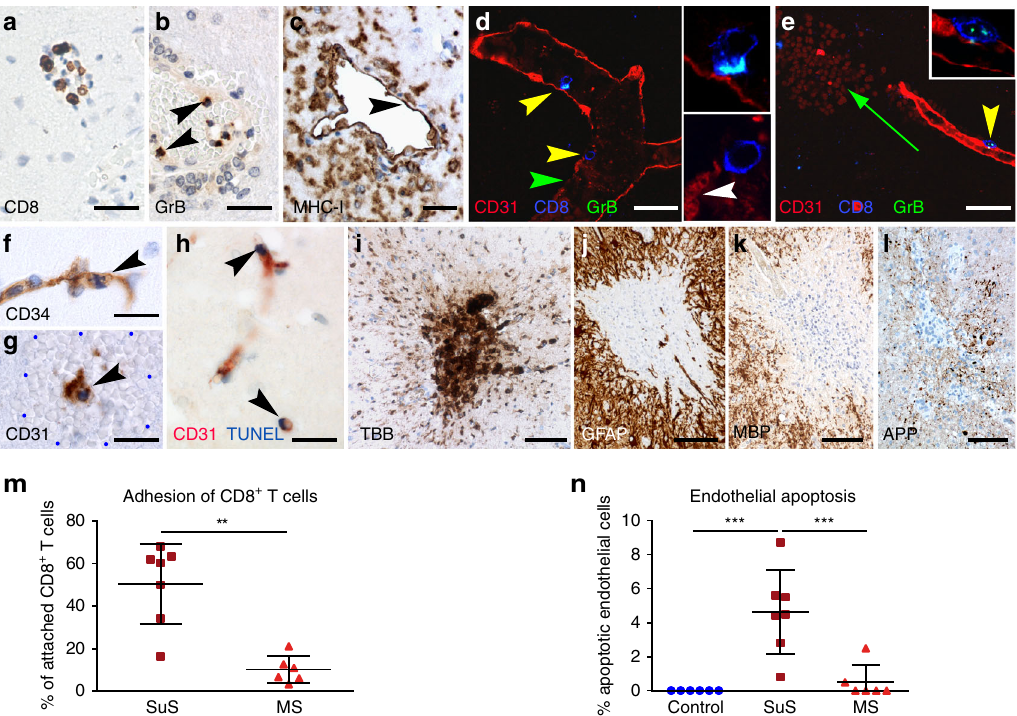
Fig. 4 CTLs accumulate in damaged microvessels of SuS patients CNS biopsies of SuS patients ( n = 7). a Accumulation of CD8 + T cells (brown) in a brain microvessel. b GrB + cells in a brain microvessel; arrowheads indicate GrB + cells attached to the vessel wall. c MHC class-I expression on ECs (arrowhead). Several leukocytes adhere to the endothelium. d Yellow arrowheads point to CD8 + T cells (blue) attached to CD31 + ECs (red). The enlargement of the upper CD8 + T cell shows its GrB + (green) granules polarized toward the ECs. Owing to close proximity of the green GrB + granules to the blue CD8 + cell membrane, these granules have a cyan blue color. The lower CD8 + T cell is migrating through the damaged (white arrowhead) vessel wall. e The same triple staining for GrB (green), CD8 (blue), and CD31 (red) shows a cytotoxic T cell attached to an intact vessel wall (yellow arrowhead). The upper left corner shows a microhemorrhage (green arrow) with parenchymal erythrocytes. f An apoptotic CD31 + EC with a condensed nucleus (arrowhead) within a microhemorrhage. g Staining for CD34 shows an EC with an apoptotic condensed (arrowhead) nucleus within a microhemorrhage encircled by the blue dots. h TUNEL-positive nuclei (arrowheads) of CD31 + ECs. i Turnbull blue (TBB) shows iron deposition around a blood vessel.